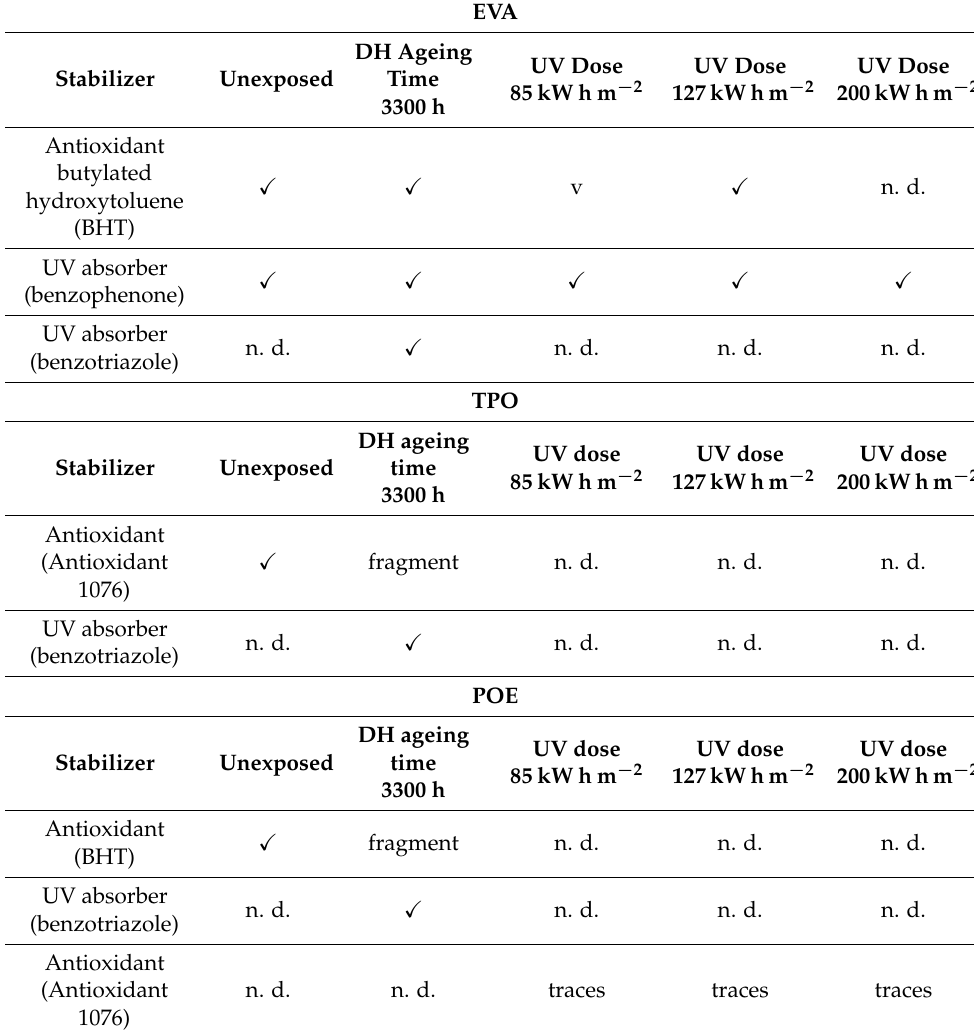
Table 3. Summary of thermal desorption gas chromatography coupled to mass spectrometry (TD- GCMS) measurements on the encapsulants exposed to damp heat (DH) and ultraviolet (UV)